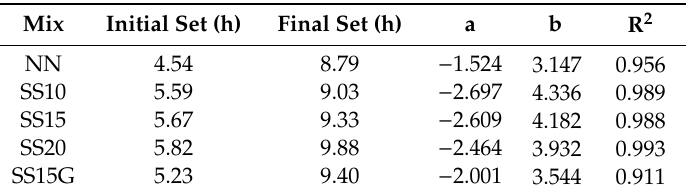
Table 3. Regression results of initial and final setting.